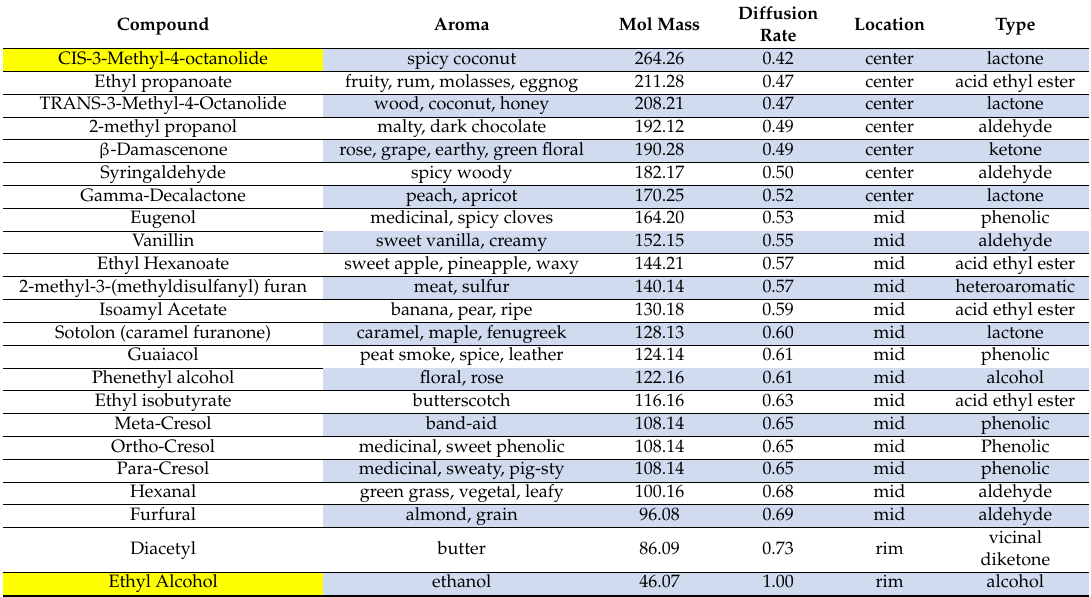
Table 7. Diffusion rates of many aromas of distillate compounds. Comparing two of the mixed gasses, highlighted in yellow; CIS-3-Methyl-4-octanolide, mol mass 264.26 gm/mole, and ethanol, mol mass 46.07 gm/mole, the lactone rate of diffusion is 42% of ethanol, slowest to diffuse, and detected near center rim plane. Ethanol diffuses fastest and is the most abundant molecule detectable at the vessel rim lip. Slowly sniffing at the rim plane confirms aroma